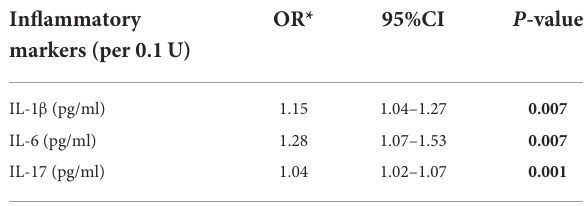
TABLE 4 Multivariable analysis for inflammatory markers associated with NAFLD. Inflammatory markers (per